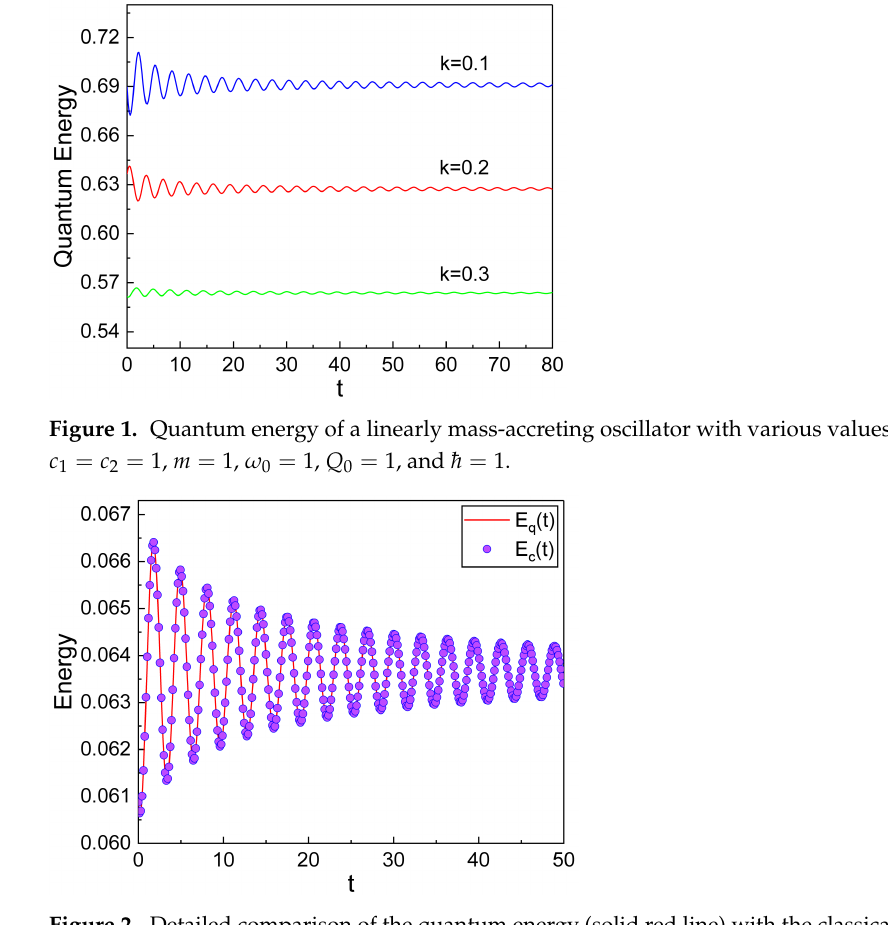
Figure 2. Detailed comparison of the quantum energy (solid red line) with the classical energy (thick dotted blue line) for linearly mass-accreting oscillator, under the limit ¯ h → 0 for the quantum energy. We used c 1 = c 2 = 1, m = 1, k = 0.1, ω 0 = 1, and Q 0 =